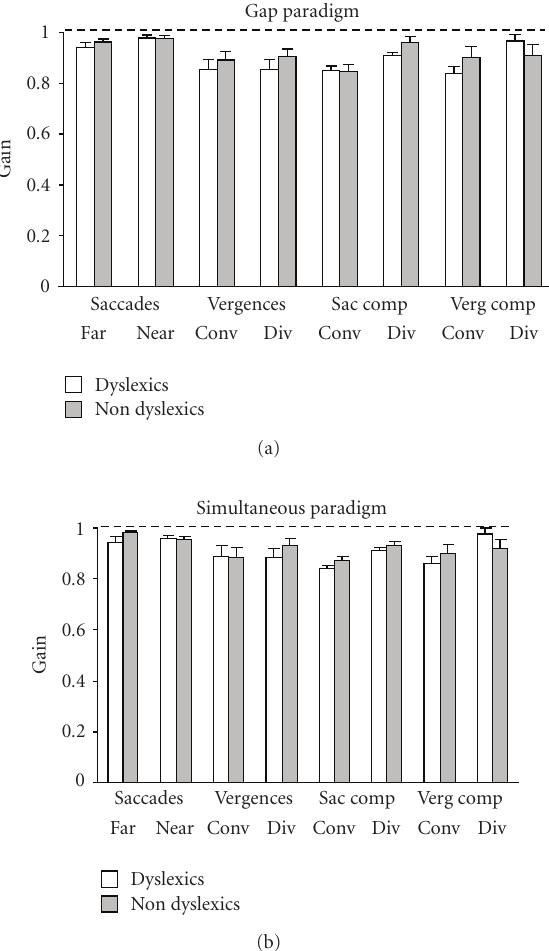
Figure 3: Mean gain (amplitude of the movement/target excursion) of di ff erent types of eye movements in the gap and in the simultaneous paradigm for dyslexic (white bars) and non-dyslexic reader (gray bars) children. Vertical lines indicate standard